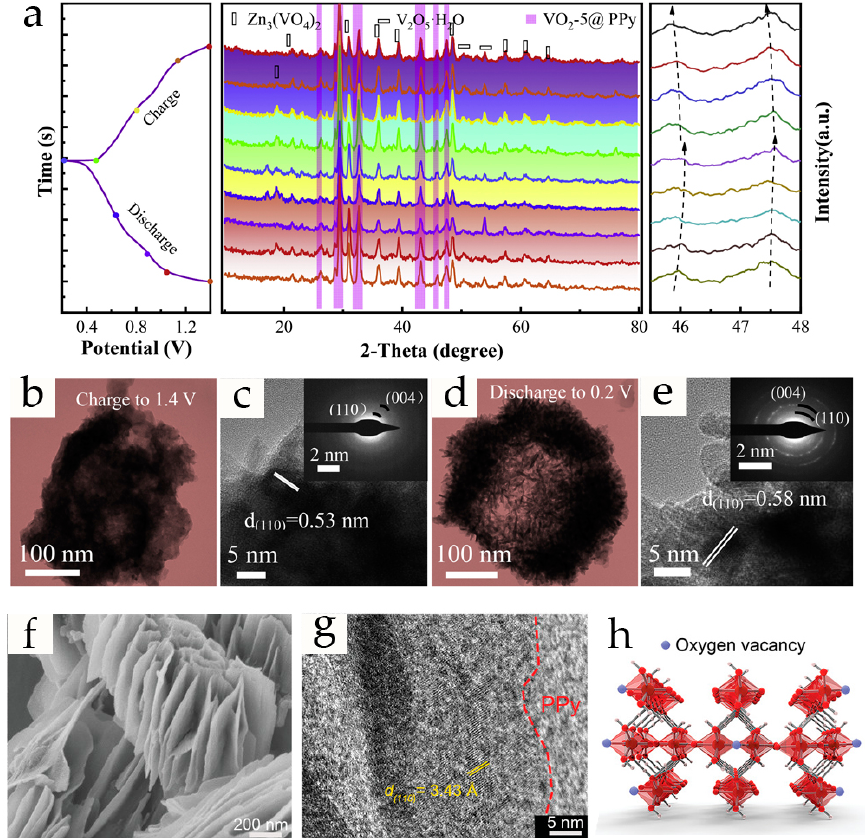
Figure 5. ( a ) Ex situ XRD patterns of VO 2 -5@PPy electrode at various charge/discharge states [16]; ( b , c ) TEM and HRTEM images of VO 2 -5@PPy charging at 1.4 V [16]; ( d , e ) TEM and HRTEM images of VO 2 -5@PPy discharging at 0.2 V [16]; ( f ) FESEM image of Od − HVO@PPy nanosheets [68]; ( g )